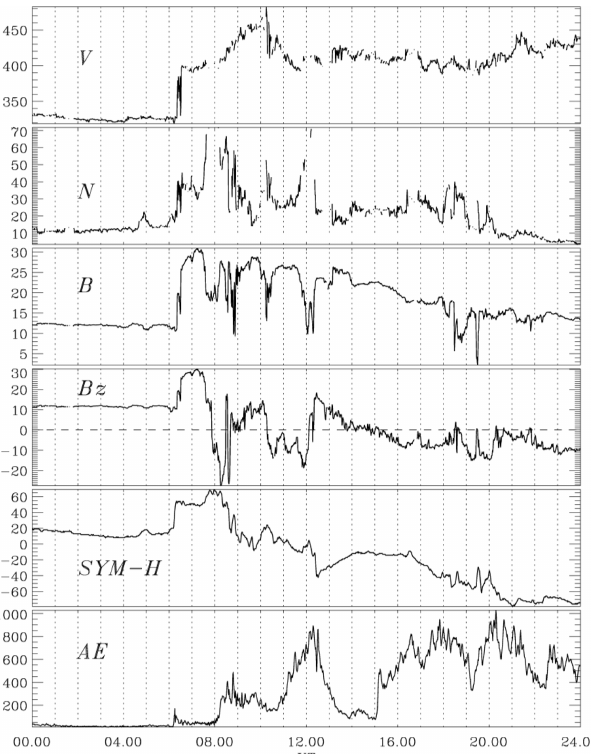
Figure 6. Ionosphere plasma density according to the EISCAT 42m radar data, phase scintillation index and amplitude scintillation in- dex according to the GPS receiver at NYA station, TEC and ROT variations according to the GPS receiver at NYA station, and ge- omagnetic field variations ( X component) at NYA station for the 22 January